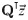
Behavior of the simulated spiking network for the MNIST dataset.
a: Behavior of the network during a typical image presentation; compare with Fig 1b. Time period of external stimulation shown by grey bar. Raster plot includes all neurons which fired at least one spike during the presentation. The spikes of the visible neurons are in the bottom row and those of the hidden neurons are directly above. The top two rows, in grey, show the spikes for the inhibitory pools at each layer. Although the each training presentation ran for 65ms, all spikes occurred before 30ms so the raster plot was ended there. b: Reconstruction loss function, black dots, (defined in text) decreases over time, as does sparsity loss function (red, note log scale on y axis). c: The trained networks’ attempted reconstruction of representative training images. Each image shows the ON cell values minus the OFF cells. The first row shows the inputs to the network. The second row shows the attempted reconstruction Q⊺z→.